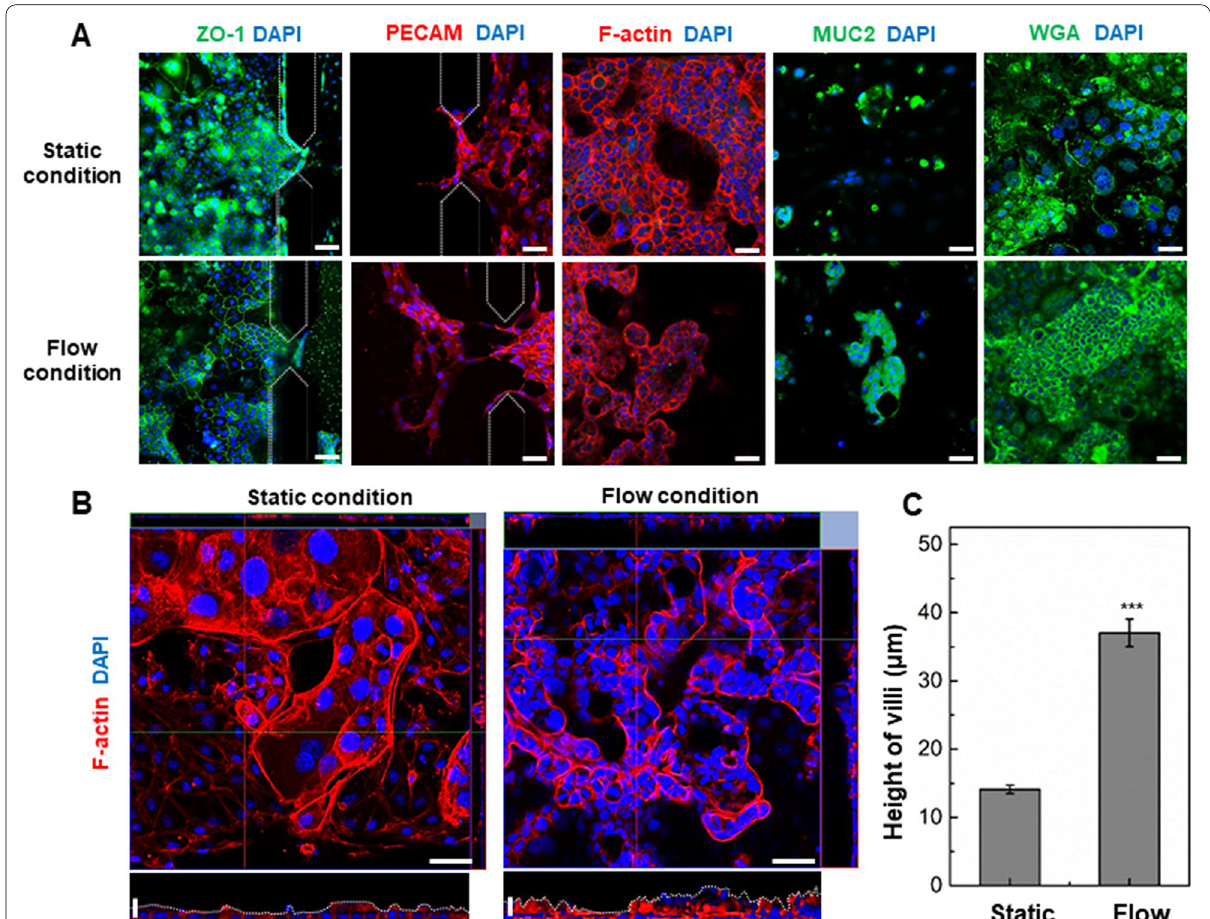
Fig. 4 Morphology of the Caco‑2 epithelial cells co‑cultured with HUVECs in a static and flow culture condition for 5 days. A Morphological analysis of intestinal specific proteins under a static and flow condition. Scale bars are 50 μm. B Morphological analysis of polarized columnar epithelium. Fluorescence confocal micrographs (vertical cross‑sectional views at 5 days after onset) show a vertical cross‑section of the epithelium highlighting cell shape and polarity. Horizontal scale bars are 50 μm and vertical scale bars are 25 μm. C The average height of Caco‑2 cells grown in the gut‑on‑a‑chip without and with fluidic flow (*** p <